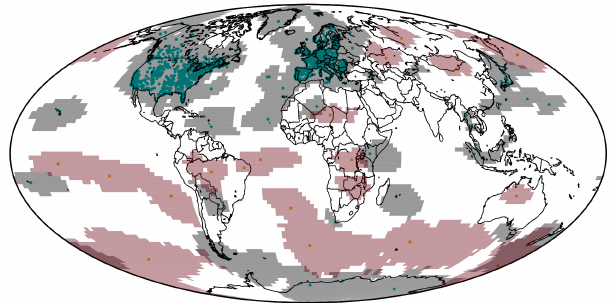
Figure 11. Map of surface ozone observational coverage as in Fig. 2 (blue dots indicate current measurement sites and gray areas their footprints) with the 20 additional sites and footprints from Figs. 9 and 10 added as red dots and pink areas to illustrate the global cov- erage if ozone measurements were made at these